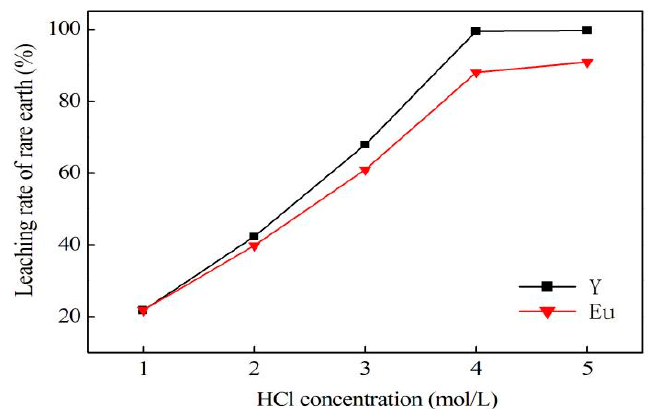
Figure 1 . Effect of HCl concentration on the rare earth element (REE) leaching test (0.2 mL/g hydrogen peroxide, 60 ° C leaching temperature, 4 h leaching time).